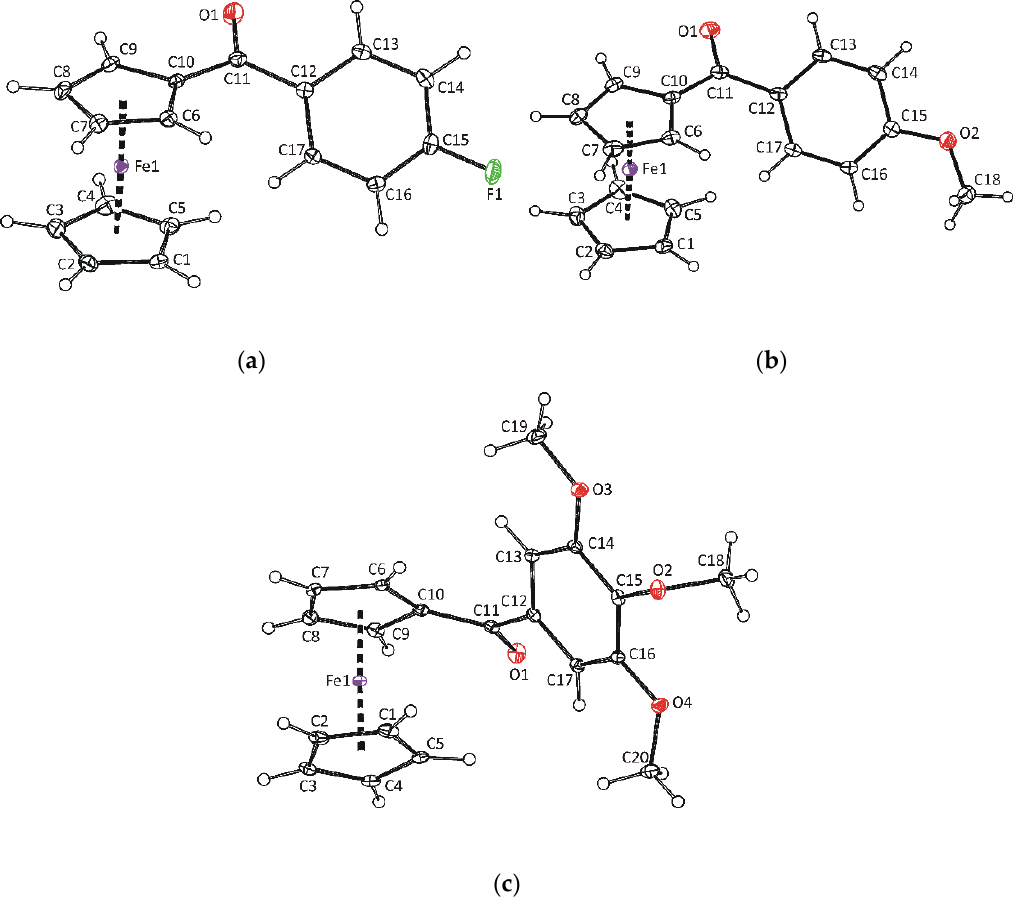
Figure 2. ORTEP drawings of: ( a ) [( η 5 -C 5 H 4 COC 6 H 4 F-4)( η 5 -C 5 H 5 )Fe] present in crystal structure of 2 ; ( b ) Molecules of [( η 5 -C 5 H 4 COC 6 H 4 OMe-4)( η 5 -C 5 H 5 )Fe] present in the crystal structure of 3 ; ( c ) Molecules of [{ η 5 -C 5 H 4 COC 6 H 2 (OMe) 3 -3,4,5}( η 5 -C 5 H 5 )Fe] present in crystal structure of 4 . Thermal ellipsoids are drawn at the 30% probability level. Table 3. Selected geometric parameters for ferrocene derivatives 1 – 4 1 .